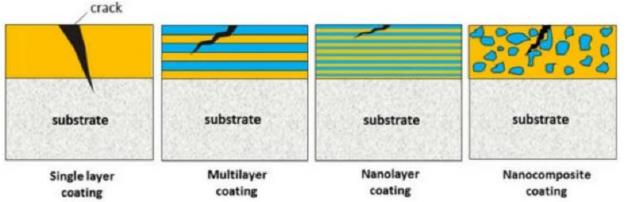
Figure 17. Crack propagation behaviour for each of the common coating structures